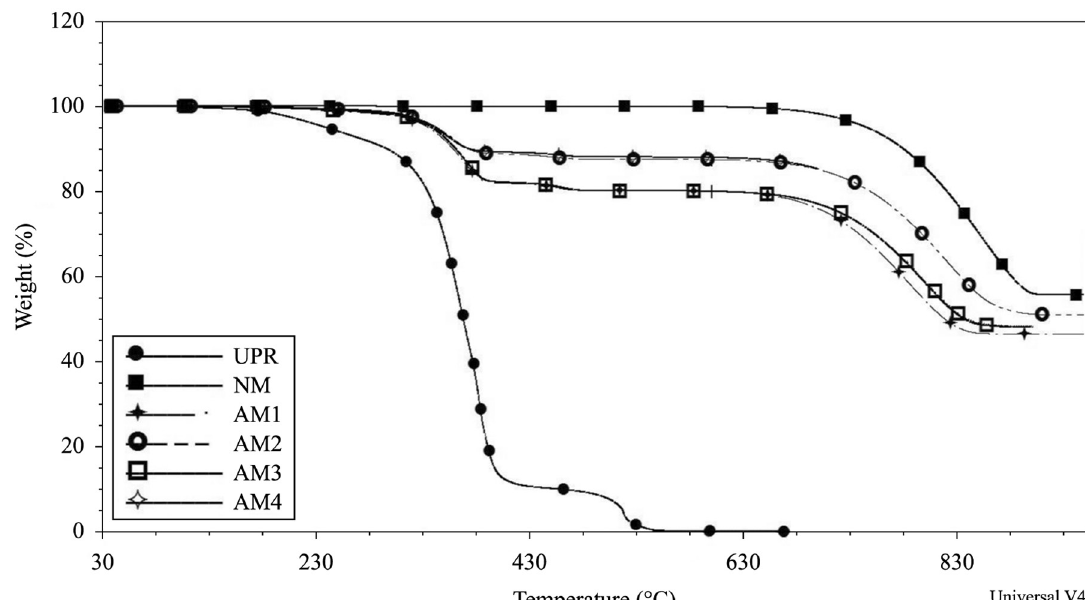
Figure 3. Thermogram for natural marble (NM), unsaturated polyester (UPR) and artificial marbles (AM1, AM2, AM3 and